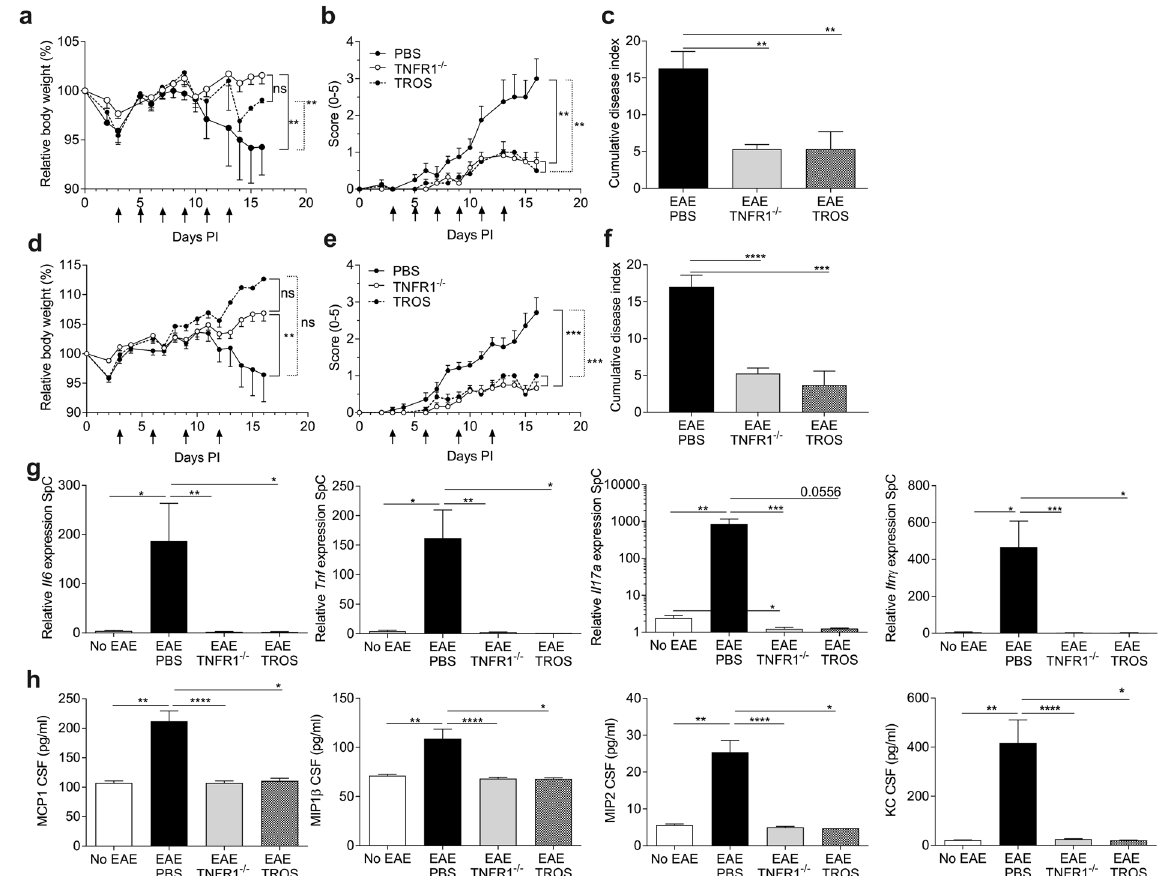
Figure 3. ( a – h ) Inhibition of TNFR1 before onset of clinical EAE symptoms protects against full-blown disease. hTNFR1 transgenic (Tg) and TNFR1 − / − mice were immunized with MOG 35-55 -peptide and pertussis toxin to induce EAE. Mice were weighed and clinically scored daily. (a – f ) hTNFR1 Tg mice were prophylactically treated on day 3 post-immunization (PI), with 200 µ g TROS or PBS intraperitoneally (i.p.) injected every two days until 13 days PI ( a – c ) or with 150 µ g TROS or PBS i.p. injected every three days until day 12 PI ( d–f ) (indicated with black arrows). Relative body weight (relative to initial body weight) ( a , d ) and clinical disease scores (scale 0-5) were assessed ( b,e ). The cumulative disease score ( c,f ) was determined 16 days PI (n = 6 PBS, n = 6 TROS and n = 6 TNFR1 − / − ). ( g ) Relative gene expression was determined using qPCR on spinal cords (SpC) isolated 16 days PI (peak of the disease) from EAE-diseased TNFR1 − / − (n = 6) and hTNFR1 Tg mice subjected to EAE and treated with 200 µ g TROS (n = 4) or PBS (n = 10) (according to the treatment regimen described in Fig. 3a–c) and from healthy hTNFR1 Tg mice (no EAE, n = 4). ( h ) Chemokines were determined in cerebrospinal fluid (CSF) 16 days PI (peak of the disease) from EAE-diseased TNFR1 − / − (n = 6) and hTNFR1 Tg mice that were treated with 200 µ g TROS (n = 2) or PBS (n = 10) (according to the treatment regimen described in Fig. 3a–c) and from healthy hTNFR1 Tg mice (no EAE, n = 4). Data information: qPCR was normalized to stable housekeeping genes. Bars represent mean ± SEM. Clinical scores were analyzed as repeated measurements using the restricted maximum likelihood (REML) variance components analysis, and all qPCR and Luminex data were compared with a Mann-Whitney test. * 0.01 ≤ p < 0.05; ** 0.001 ≤ p < 0.01; *** 0.001 ≤ p 0.0001, **** p < 0.0001. Non-statistically significant differences are not indicated on the